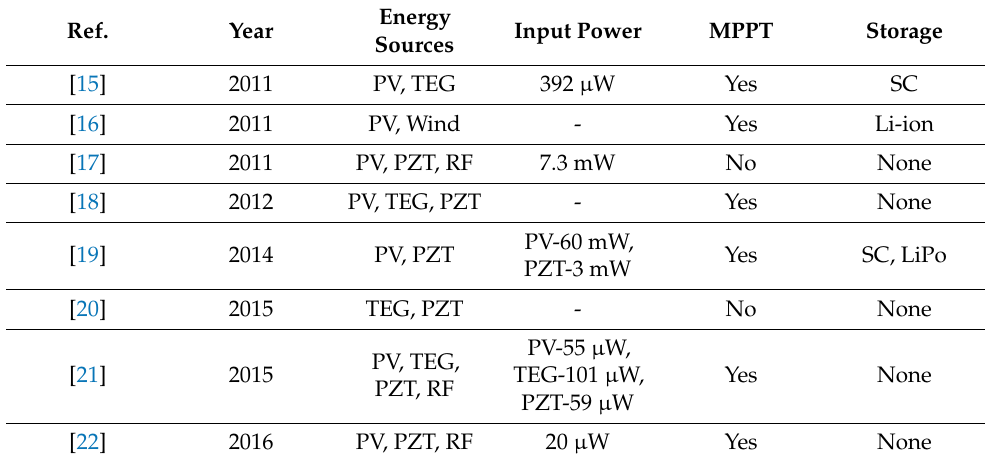
Table 1. Comparison of different hybrid energy harvesting systems. Ref. Year